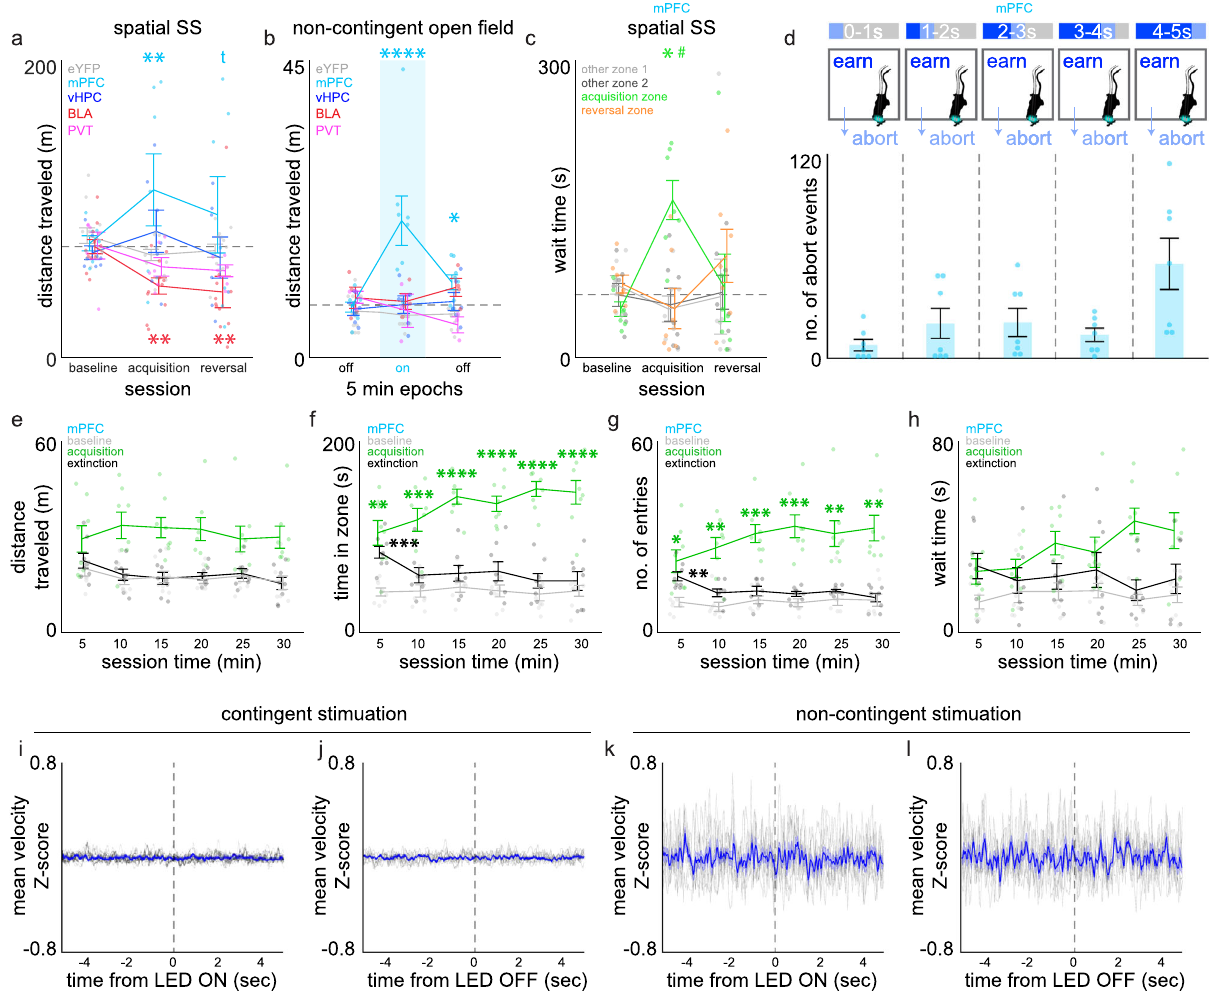
Fig. 4 Disconnects between locomotor activity and reward-directed behaviour in mPFC → NAcSh mice. a Total distance traveled (m) during spatial self- stimulation (SS) sessions in eYFP (gray, n = 12 mice), mPFC → NAcSh (cyan, n = 7), vHPC → NAcSh (blue, n = 7), BLA → NAcSh (red, n = 11), and PVT → NAcSh (pink, n = 6) mice. Contingent stimulation (30 Hz) increased total distance traveled in mPFC → NAcSh and decreased it in BLA → NAcSh mice. b Total distance traveled (m) during 5 min epochs in eYFP (gray, n = 12), mPFC → NAcSh (cyan, n = 8), vHPC → NAcSh (blue, n = 6), BLA → NAcSh (red, n = 4), and PVT → NAcSh (pink, n = 3) mice. Non-contingent stimulation (30 Hz, 5 s on, 5 s off during on epoch highlighted in blue) increased distance traveled, but only in mPFC → NAcSh mice. c Total time spent waiting in the corner zones during the timeout period across contingent self- stimulation sessions in mPFC → NAcSh mice. d The number of active zone abort stimulation decisions made by mPFC → NAcSh mice during acquisition expressed across progressive 1 s time bins within the 5 s stimulation duration. e – h Behaviour exhibited in the across (5 min bins) baseline (gray), acquisition (green), and extinction sessions (black) in mPFC → NAcSh mice ( n = 8). e Total distance traveled (m) across the entire arena, ( f ) Time spent in the stimulation-paired active zone, ( g ) Entries made into the stimulation-paired active zone, ( h ) Time spent waiting in active zones during the timeout period. i , j Velocity Z-scores during contingent stimulation onset ( i ) or offset ( j ) during acquisition in mPFC → NAcSh mice. k , l Velocity Z-scores during non-contingent stimulation onset ( k ) or offset ( l ) during acquisition in mPFC → NAcSh mice. Note that differences in velocity amplitudes between contingent and non-contingent conditions is likely related to differences in apparatus dimensions. Data is expressed as mean ± SEM. Analysis was done using mixed-model ANOVAs ( a , b ), two-way ANOVA ( c ), one-way ANOVA ( d ), two-way repeated measures ANOVAs ( e – h ), or paired two-tailed t -tests ( i , j ) tp < 0.1, * p < 0.05, ** p < 0.01, *** p < 0.001, **** p < 0.0001 versus baseline session (contingent) or fi rst off epoch (non-contingent). # p < 0.05 versus other corner zones, within same session using Student ’ s ( a , b ) or Tukey ’ s ( c , f , g ) post hoc these mice revealed a signi fi cant session x zone interaction on stimulation (Fig. 4d, F 4,30 = 4.3049, p = 0.0072, ɳ 2 = 0.36). Taken wait times (Fig. 4c, F 6,72 = 3.1649, p = 0.0082, ɳ 2 = 0.25). Post- together, these data indicate that activation of mPFC → NAcSh hoc comparisons further revealed that these elevations in wait mice inputs was producing purposeful changes in locomotor time occurred selectively within the active zone during the activity that were associated with the repeated actions being taken acquisition session, despite locomotor activity being elevated at in these mice across the self-stimulation sessions. this time. Thus, mice were indeed capable of remaining in the active zone beyond the initial 5 s of stimulation. A one-way Preservation of behaviour in mPFC → NAcSh mice when sti- ANOVA analysis of the number of abort events across 1 s time mulation is discontinued . To further con fi rm that locomotor bins during the 5 s stimulation bouts also indicated that these events occurred across varying times points after the initiation of activity was associated with repeated actions in mPFC → NAcSh